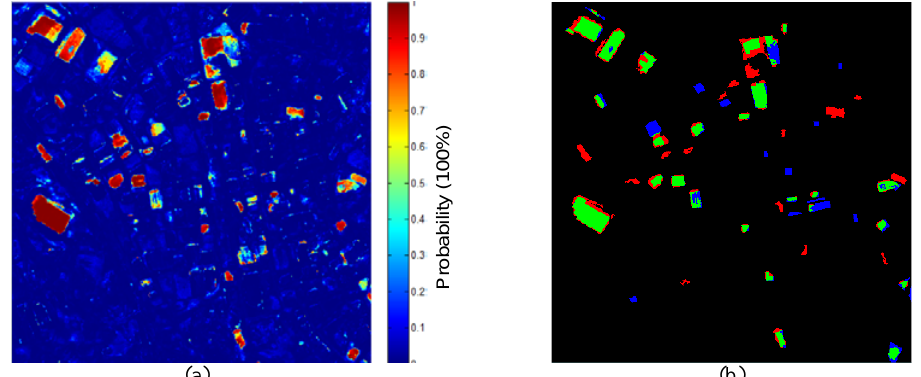
Figure 8. Change map (a) and change mask (b) generated in the Istanbul test area with Method